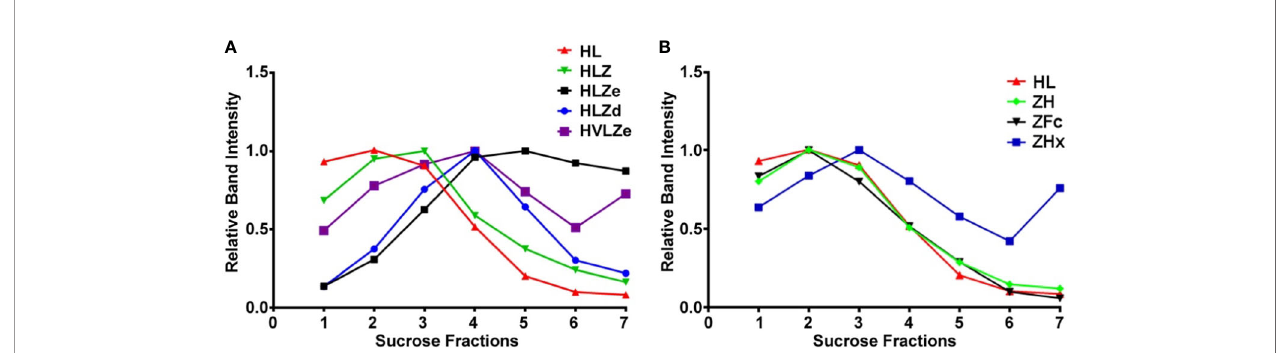
FIGURE 4 | Sucrose gradient centrifugation of IgG fusions. Puri fi ed IgG fusions were separated by sucrose gradient sedimentation using 5/10/15/20/25% discontinuous sucrose layers. Gradient fractions were analyzed by SDS-PAGE and representative results are shown; direction of sedimentation is left to right. The relative band intensity was quanti fi ed using ImageJ software and the peak band was arbitrarily assigned the value of 1. Sedimentation pro fi les were plotted on two separate graphs. (A) constructs HL, HLZ, HLZe, HLZd, and HVLZe. (B) constructs HL, ZH, ZFc, and ZHx. The plot for HL represents the same data for both (A, B)